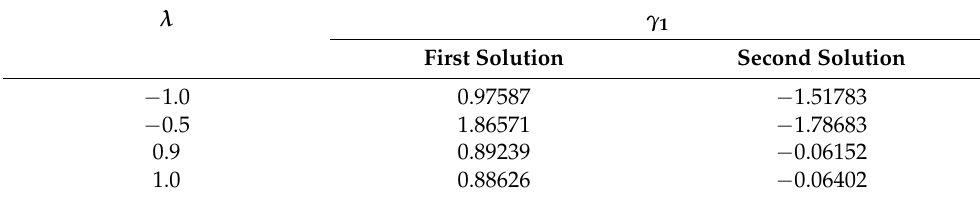
Table 3. Smallest eigenvalue, γ 1 for Pr = 6.2, A = − 0.5, φ Al and R =